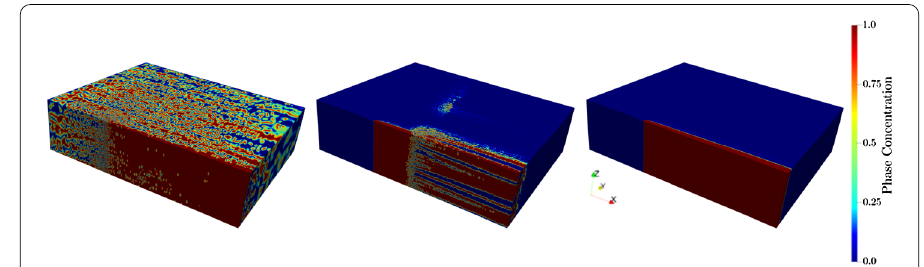
Figure 5 Numerical solution of the liquid phase equation with FEM. Left: full convection equation (13), middle: with artificial diffusivity (31), right: with artificial diffusivity and SUPG